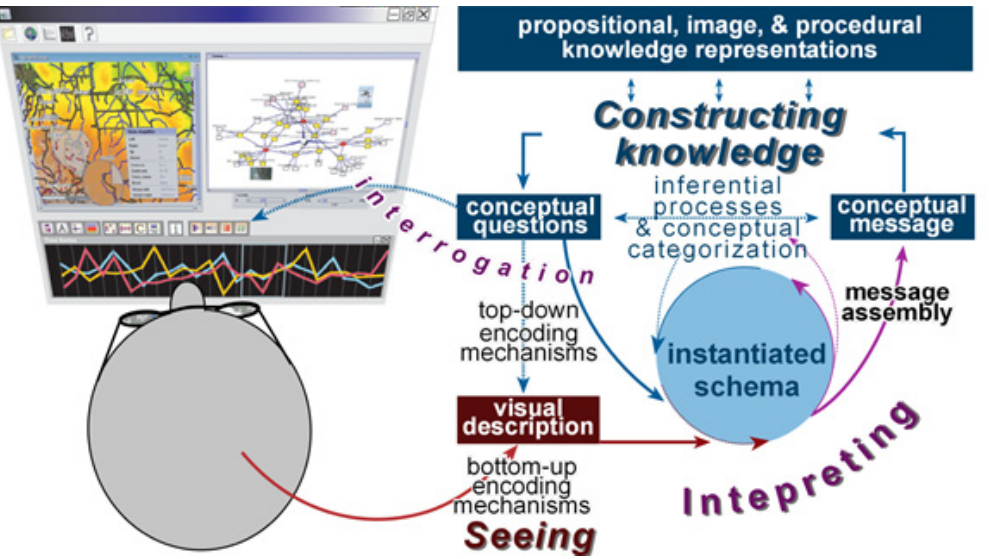
Figure 2: Feature-ID model of geovisualization; elaboration of ideas first presented in Fig- ure 8.1 in [128]. The model focused on identifying key components in visually-enabled reasoning about geographic phenomena and